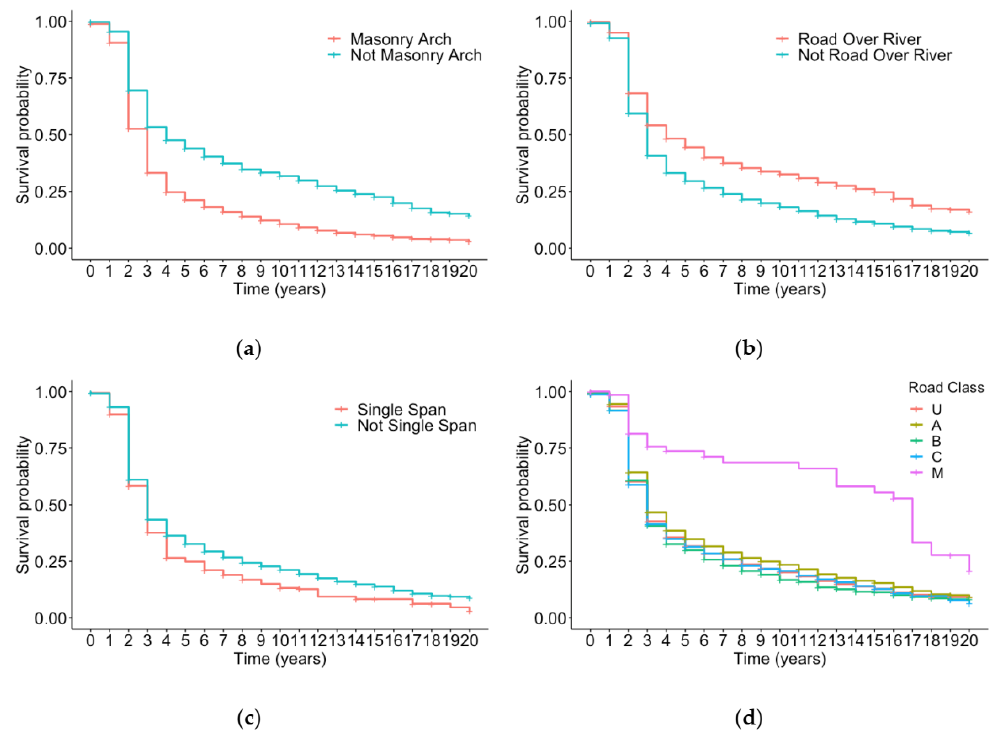
Figure 3. Kaplan–Meier survival curve for time spent in condition state 1 stratified by: ( a ) the bridge being masonry arch or not; ( b ) the bridges function being road over river or not; ( c ) the bridge being single span or not; ( d ) the road